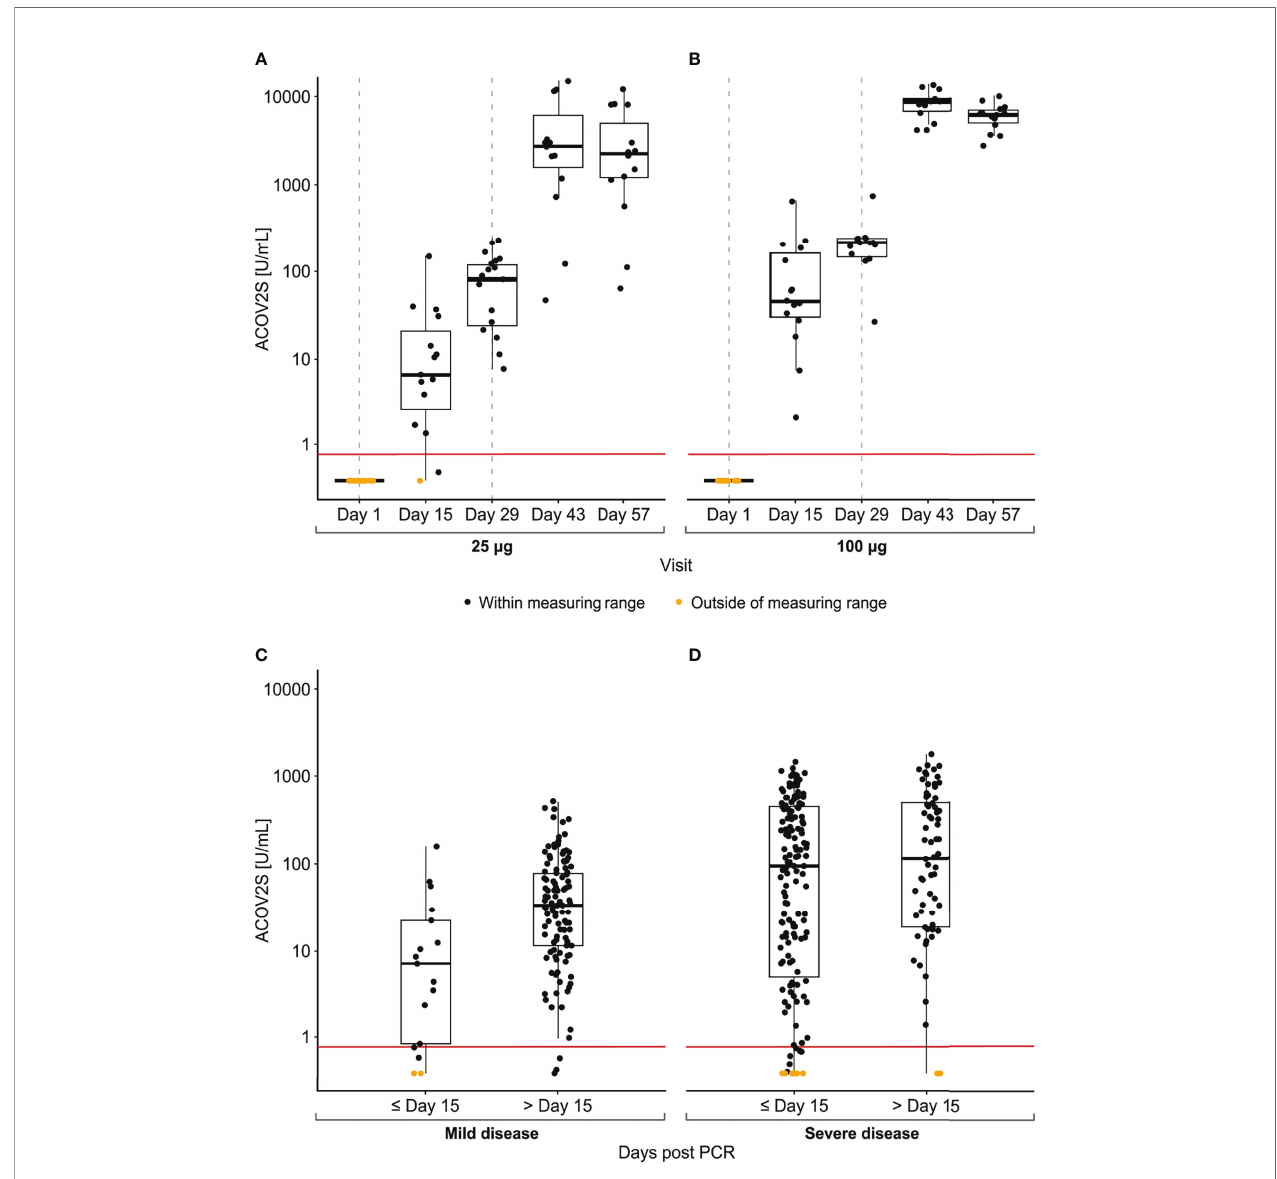
FIGURE 2 | Time course of ACOV2S-measured antibody levels following mRNA-1273 vaccination and native infection. Antibody levels following vaccination are shown in (A, B) ; dotted grey vertical lines indicate time of vaccination, administered at Days 1 and 29. Antibody levels in samples post PCR-con fi rmed SARS-CoV-2 infection are shown in (C, D) . Box plots show the individual readouts (black dots) and, 25 th , 50 th , and 75 th percentiles (black box). Red horizontal line indicates reactivity cut-off (0.8